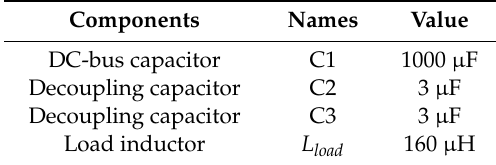
Table 2. The value of electrical parameter of components in DPT rig.